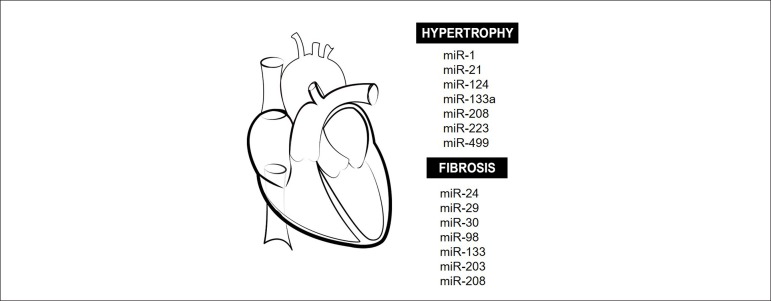
Cardiac remodeling and miRNAs. Main miRNAs that modulate cardiac
hypertrophy and tissue fibrosis during adverse cardiac remodeling in
many diseases are here illustrated.